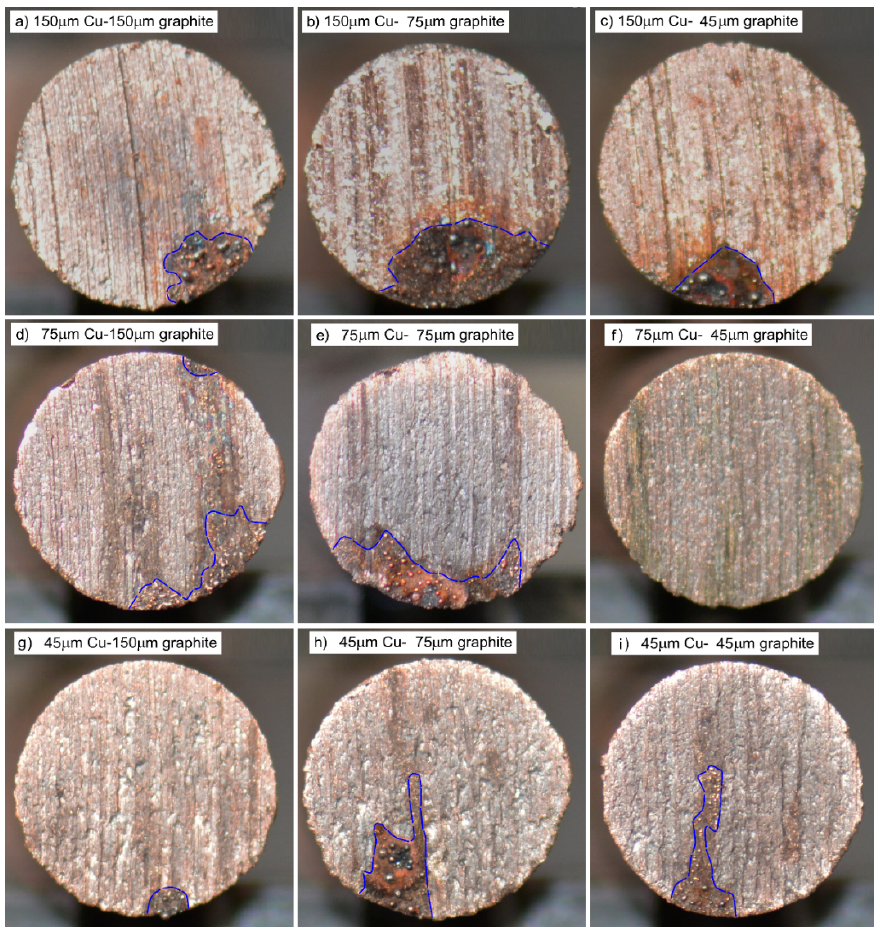
Figure 6. The macroscopic morphology of the friction surface: ( a ) 150 µ m copper–150 µ m graphite, ( b ) 150 µ m copper–75 µ m graphite, ( c ) 150 µ m copper–45 µ m graphite, ( d ) 75 µ m copper–150 µ m graphite, ( e ) 75 µ m copper–75 µ m graphite, ( f ) 75 µ m copper–45 µ m graphite, ( g ) 45 µ m copper–150 µ m graphite, ( h ) 45 µ m copper–75 µ m graphite, ( i ) 45 µ m copper–45 µ m graphite.